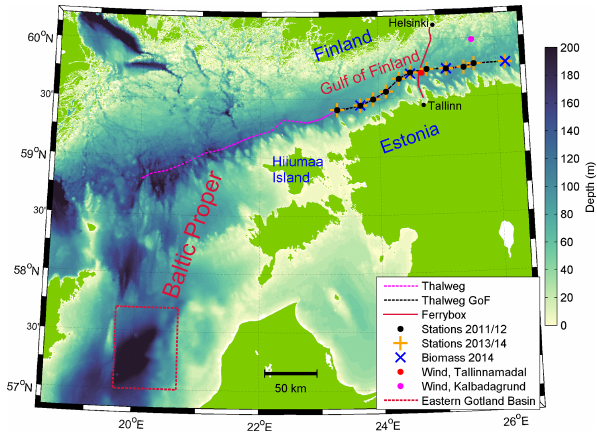
Figure 1. Bathymetric map of the Baltic Proper and the Gulf of Finland. The locations of the CTD stations along the gulf (thal- weg GoF) visited in 2011/12 and 2013/14, phytoplankton biomass sampling stations along the gulf in 2014, transect from the north- ern Baltic Proper to the central Gulf of Finland (thalweg + thalweg GoF), Tallinn–Helsinki Ferrybox line, Tallinnamadal and Kalbåda- grund wind measurements locations, and Eastern Gotland Basin (box) area are